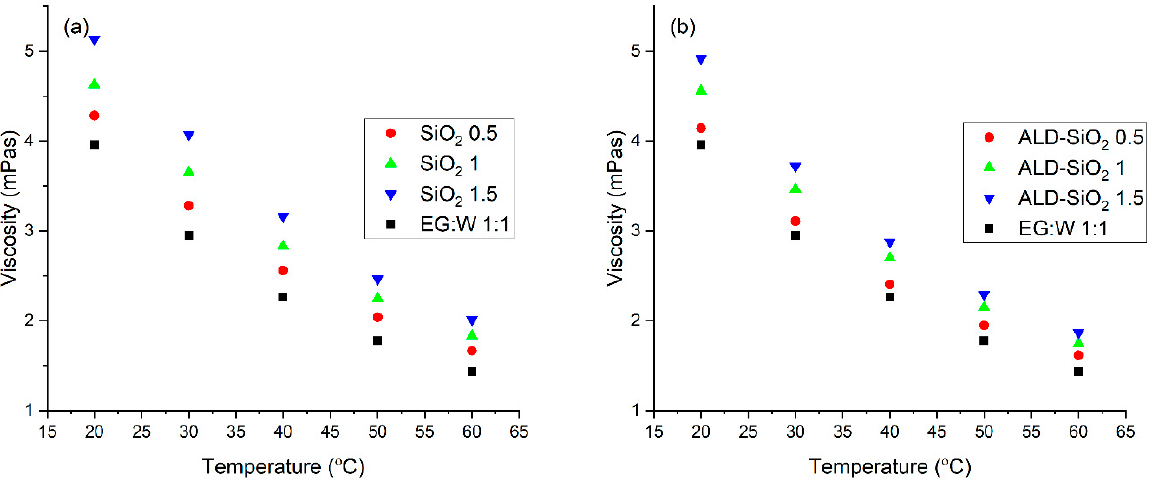
Figure 6. The viscosity of the SiO 2 ( a ) and composite nanofluids ( b ). The viscosity of all nanofluids decreased with the increase of the temperature, simi- larly to the base fluid. Not surprisingly, the increasing volume fraction of the nanoparti- cles increases the viscosity of the nanofluid, similarly to most nanofluids in general.